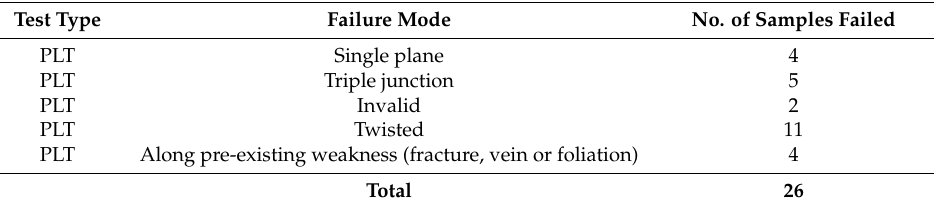
Table 2. Table with samples grouped based on their failure mode in the point load test (PLT).